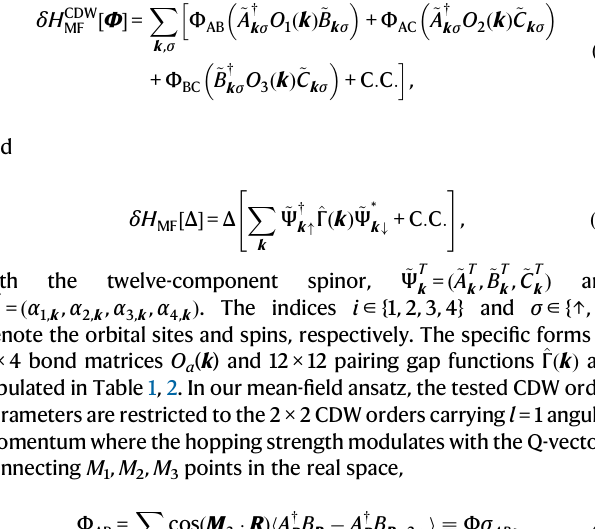
λ (cid:5) M ± ,0 a a = a areintroducedwith4×4matrices